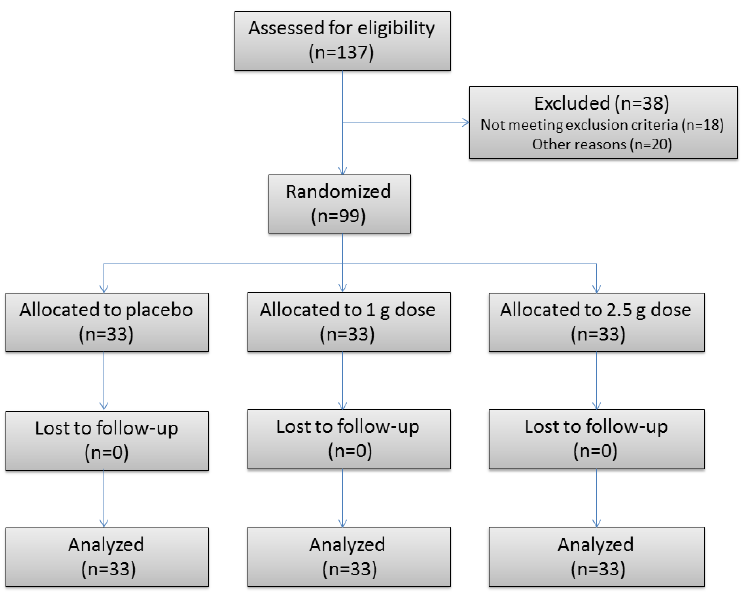
Figure 1. Flow of participants through phase 2 of the trial.